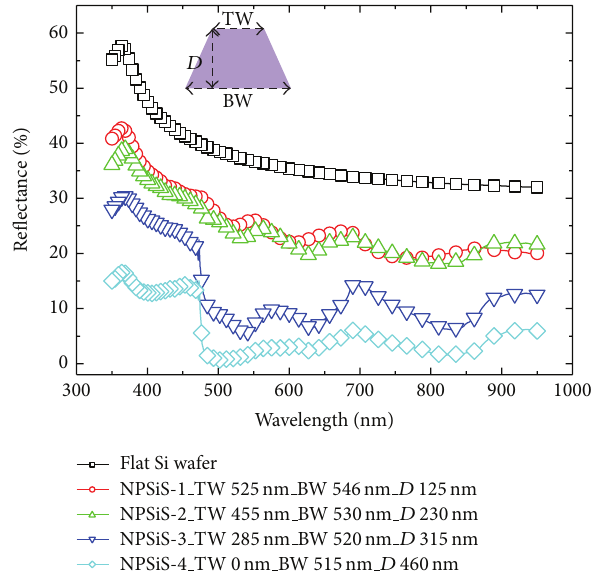
Figure 2: Using 3D-FDTD method to simulate reflectance spectra of periodic 550 nm